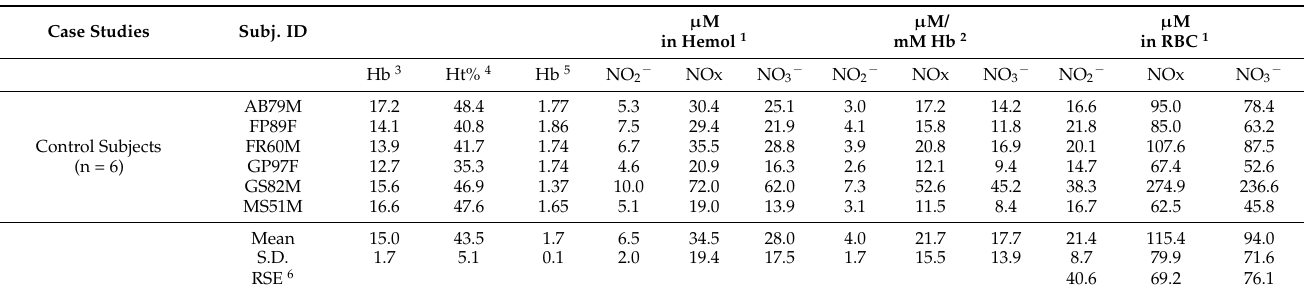
Table 6. Nitrite and nitrate concentrations in red blood cell hemolysates of the subjects used for the method performance study. Case